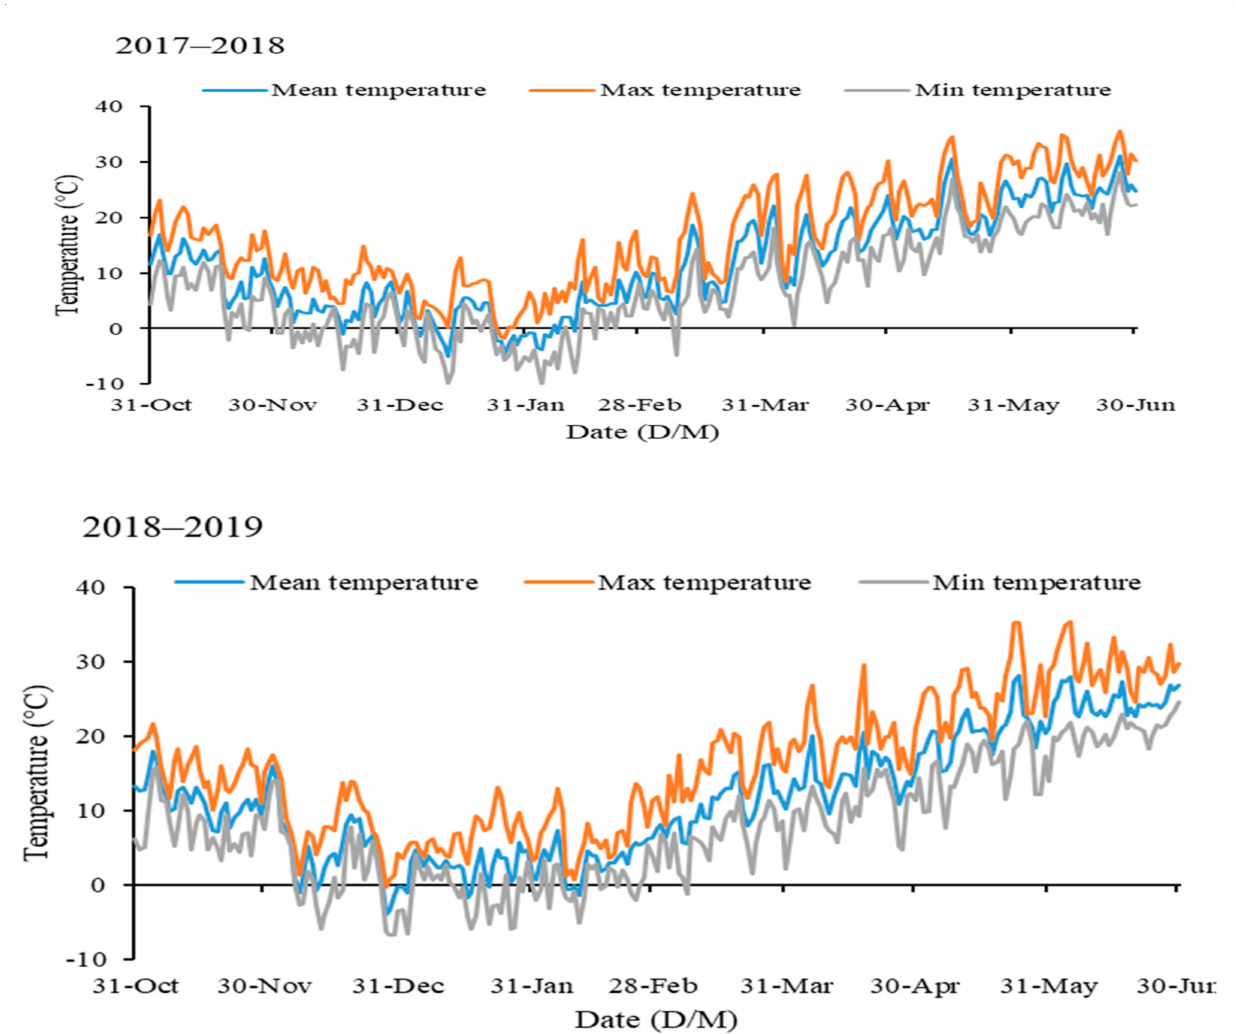
Figure 1. Daily changes in mean daily, maximum, and minimum temperatures during the experiment.